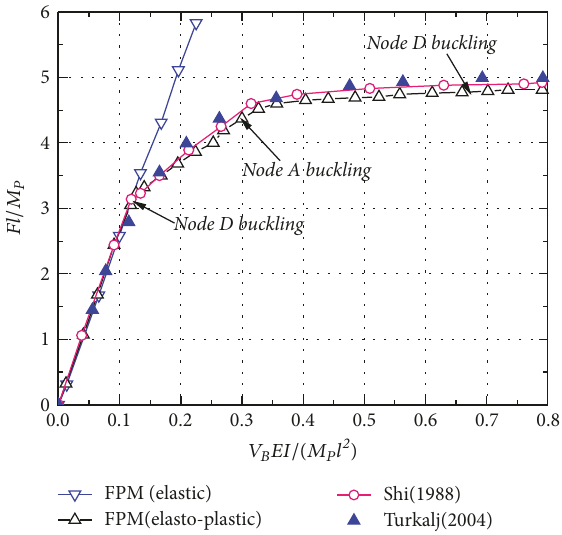
Figure 19: Nondimensional load-displacement curves of node B in the